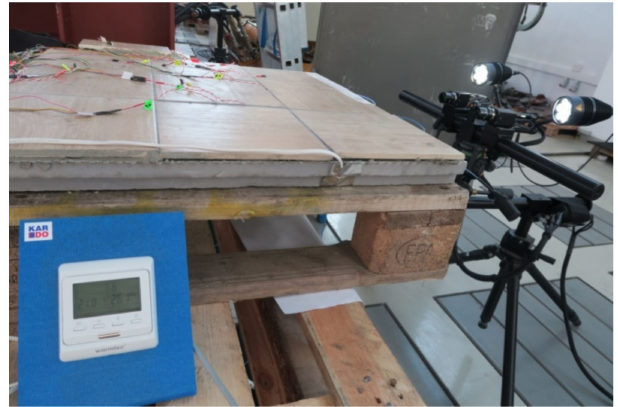
Figure 11. Aramis system test stand for measuring LFS displacements.